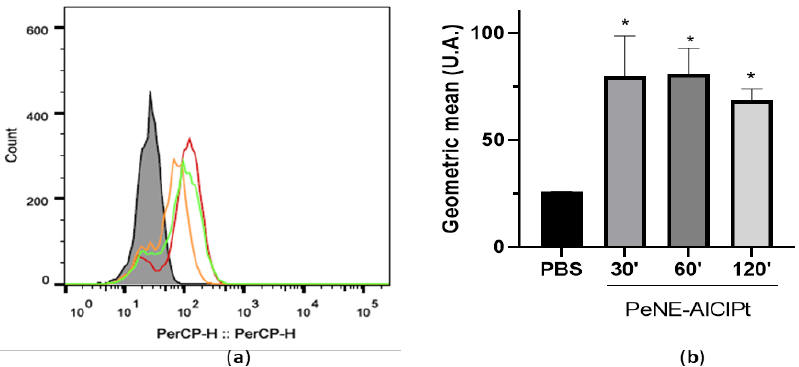
Figure 3. Association of nanoemulsions in macrophages measured by flow cytometry (10,000 events/sample) in J774-1 cells exposed to NePE-AlClPt for 30 – 60 and 120 min at 360 µg/mL. PBS was used as the control. ( a ) Histogram representation. Legend: not-treated cells (gray line); NePE-AlClPt treated cells for 30 min (green line), 60 min (red line), and 120 min (orange line). ( b ) Graphical representation. One-way ANOVA: significant difference between groups vs. control * p < 0.05 (Tukey post hoc test).